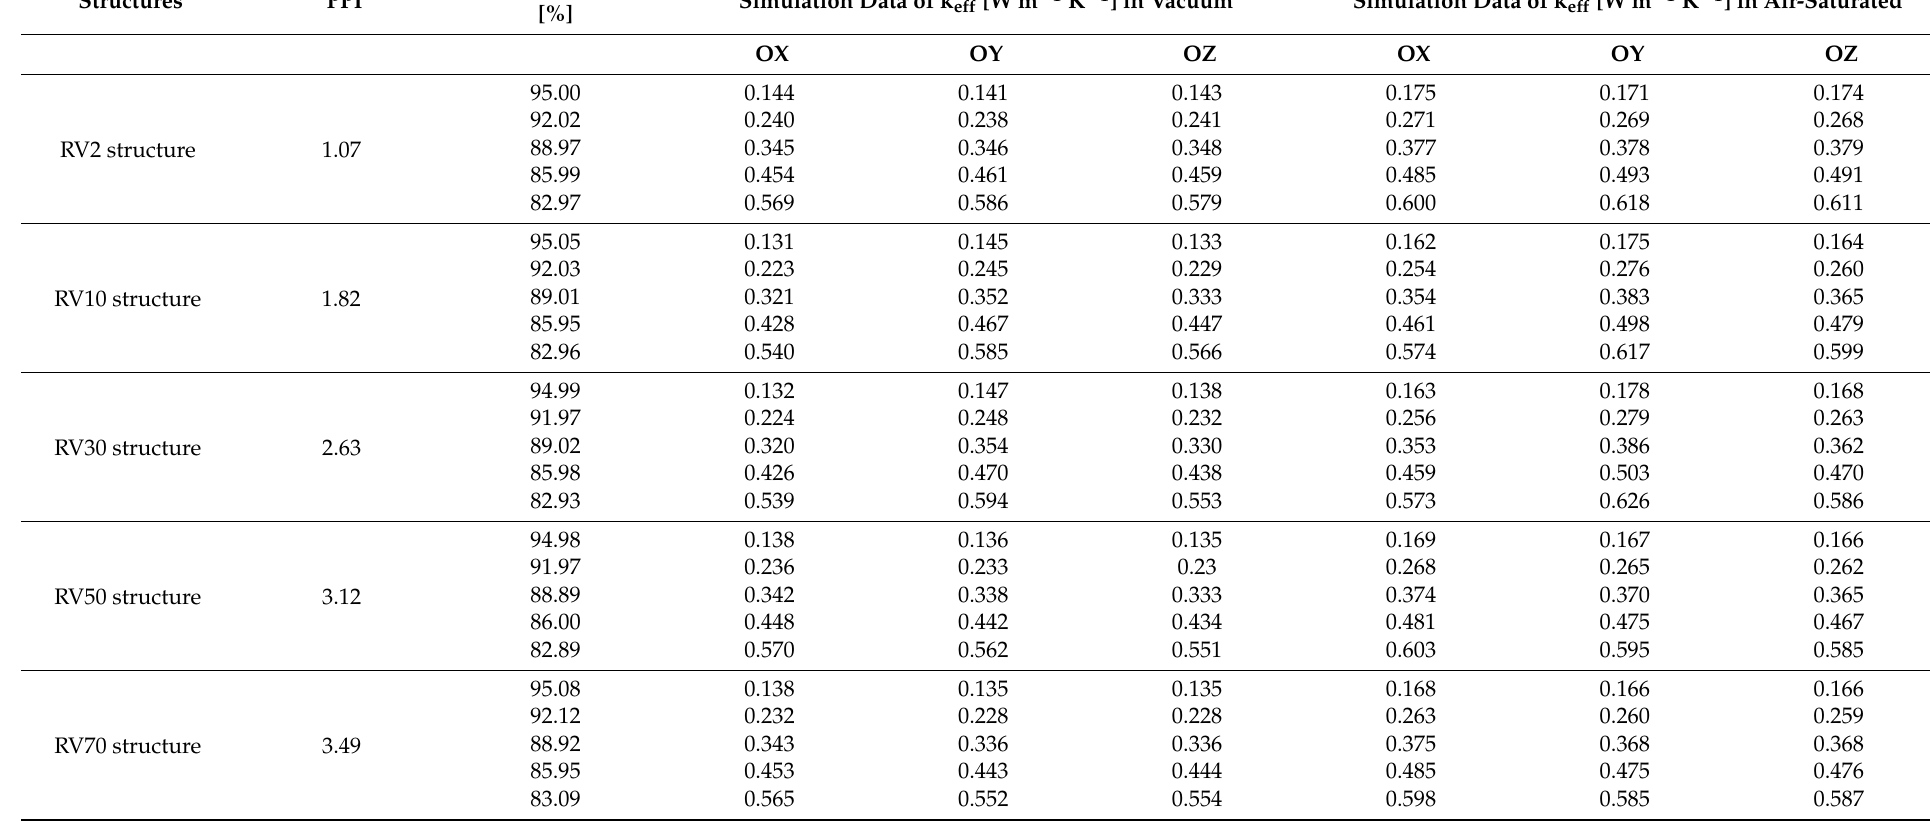
Table 3. Effective thermal conductivity of cellular structures with various porosity, number of seed points and